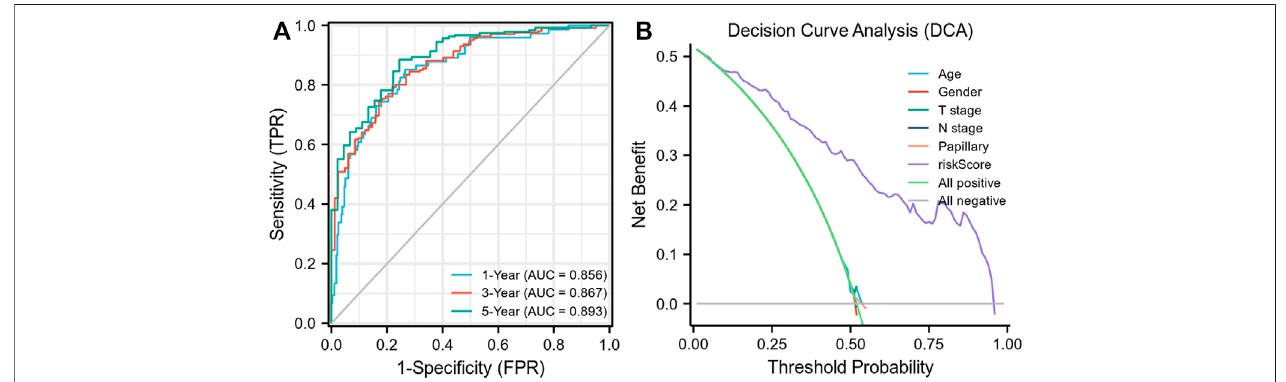
FIGURE 2 | Receiver operating curves and decision curve analysis of the risk model.